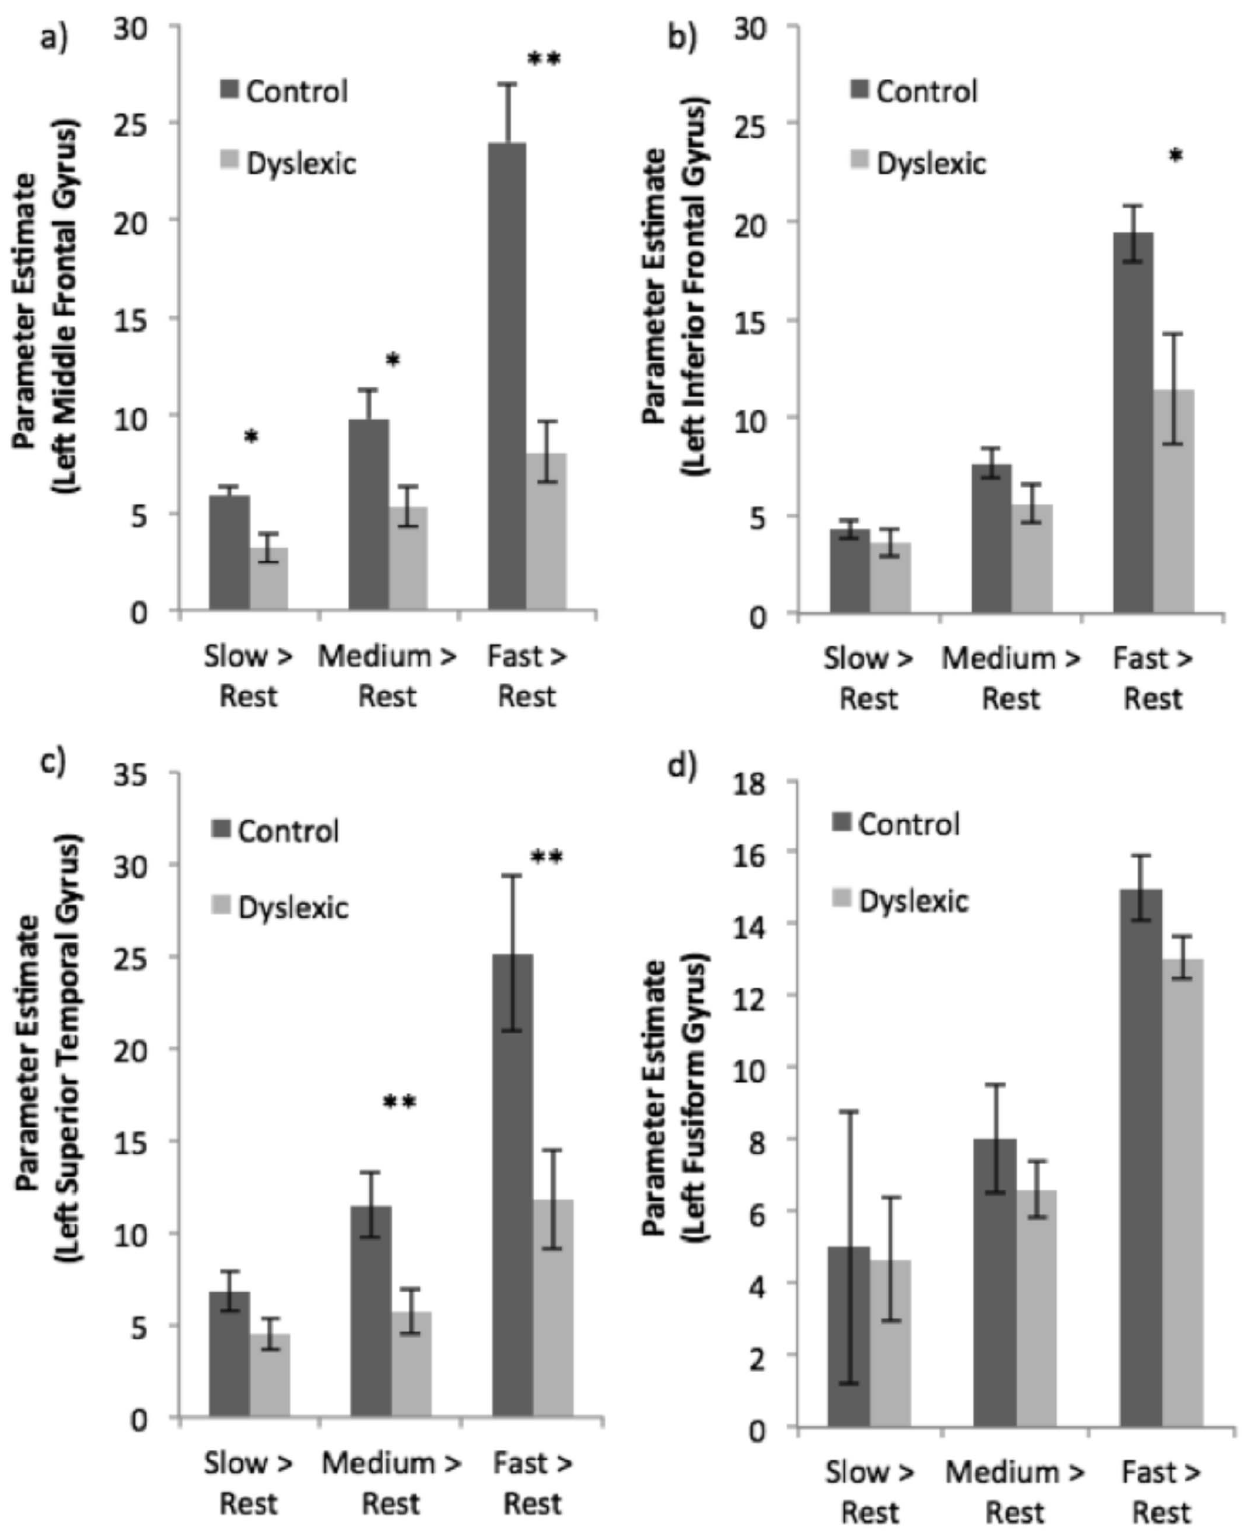
Figure 2. Comparison between Typical Reader and Dyslexic Groups (with standard error bars) showing region-of-interest activations for a) left middle frontal gyrus; b) left inferior frontal gyrus; c) left superior temporal gyrus; and d) left fusiform gyrus (visual word form area, VWFA). Note: *p , .05; **p , .01.